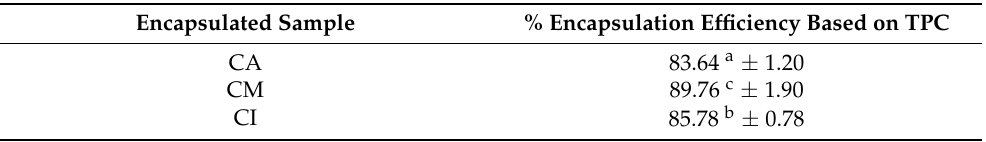
Table 3. % Encapsulation efficiency of alginate (CA), alginate/maltodextrin (CM), and alginate/inulin (CI) hydrogel beads contained in encapsulated antioxidant crude extract from CSCG. Encapsulated